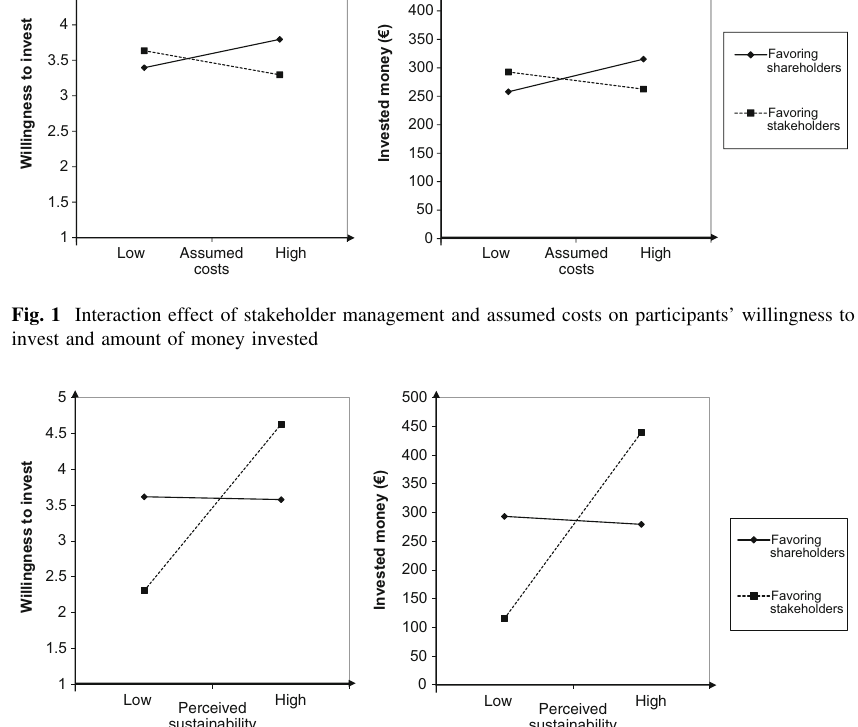
Fig. 2 Interaction effect of stakeholder management and perceived sustainability on participants’ willingness to invest and amount of money